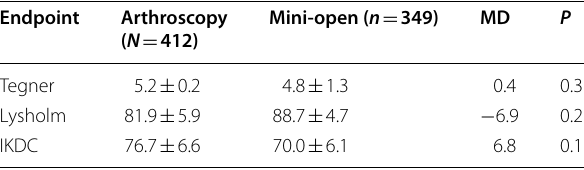
Table 4 Results of the scores